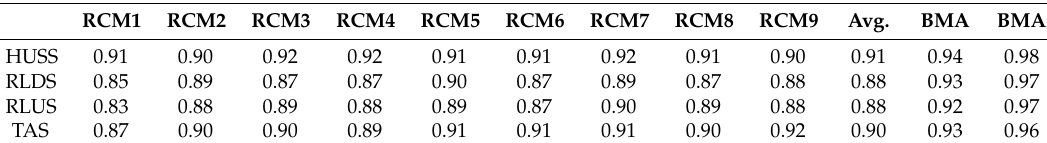
Table 4. Averages of the correlation coefficients between nine regional climate models (RCMs) and reference data.